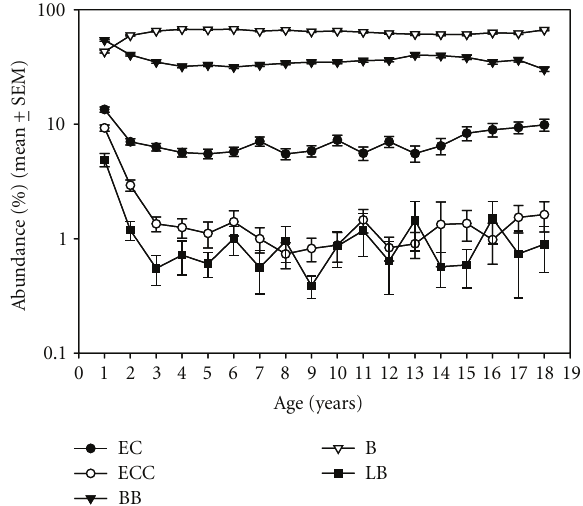
Figure 3: Abundance (%) (mean ± SEM) by age (months) of E. coli , Enterococcus sp ., as well as L actobacillus sp ., Bifidobacteria , and Bacteroides sp .